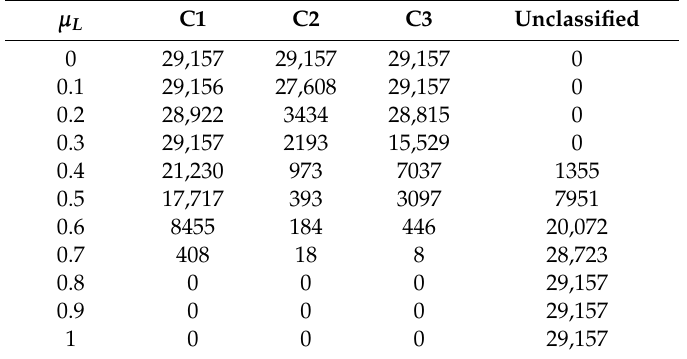
Table 2. Numbers of samples within the three categories with di ff erent µ L . Table 3. Number of samples selected for training and